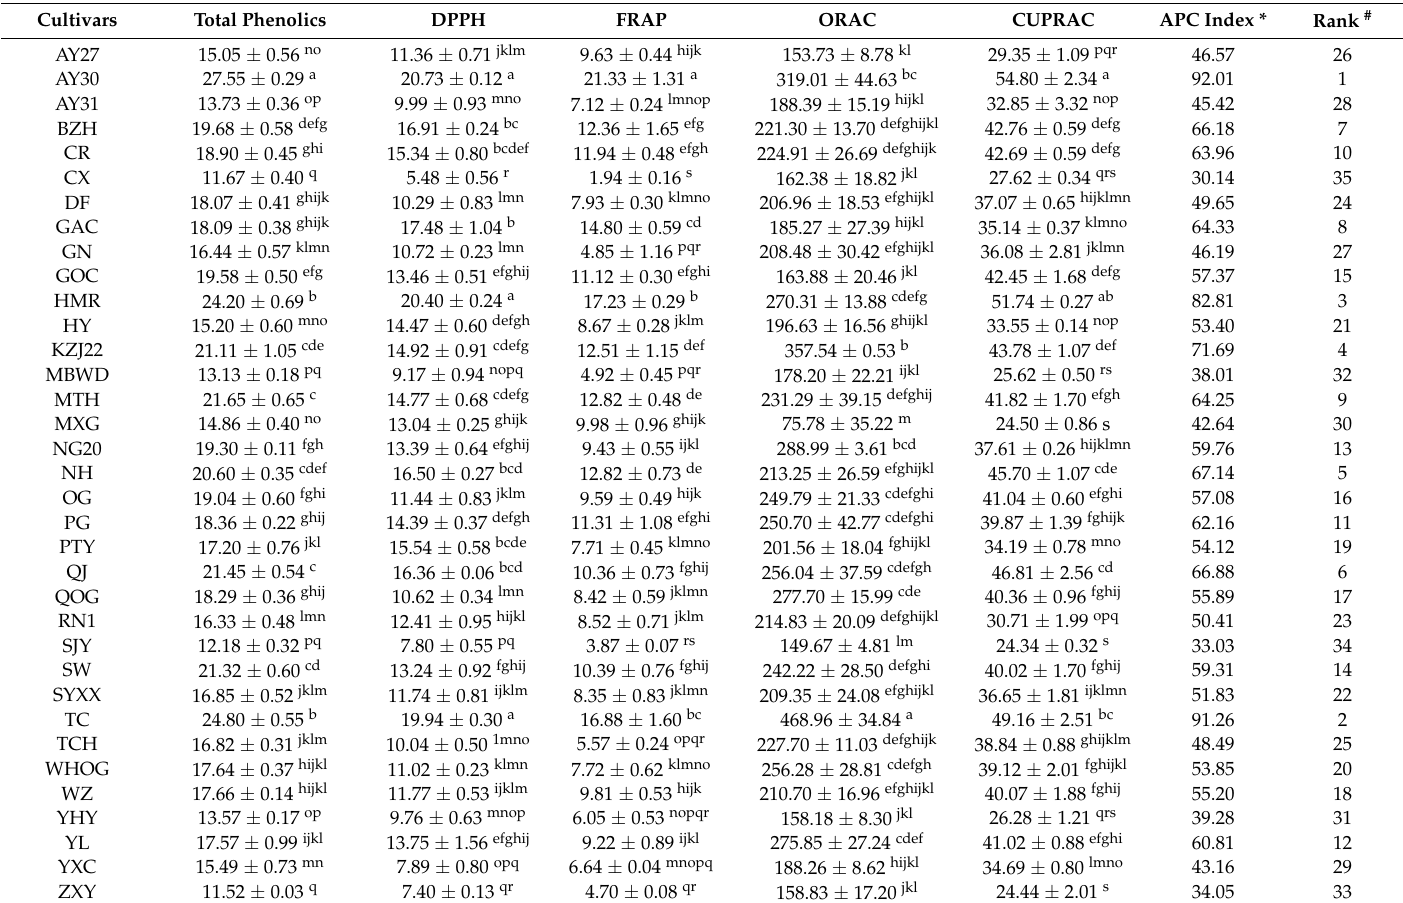
Table 2. Total phenolics and antioxidant properties of citrus fruit flavedo of 35